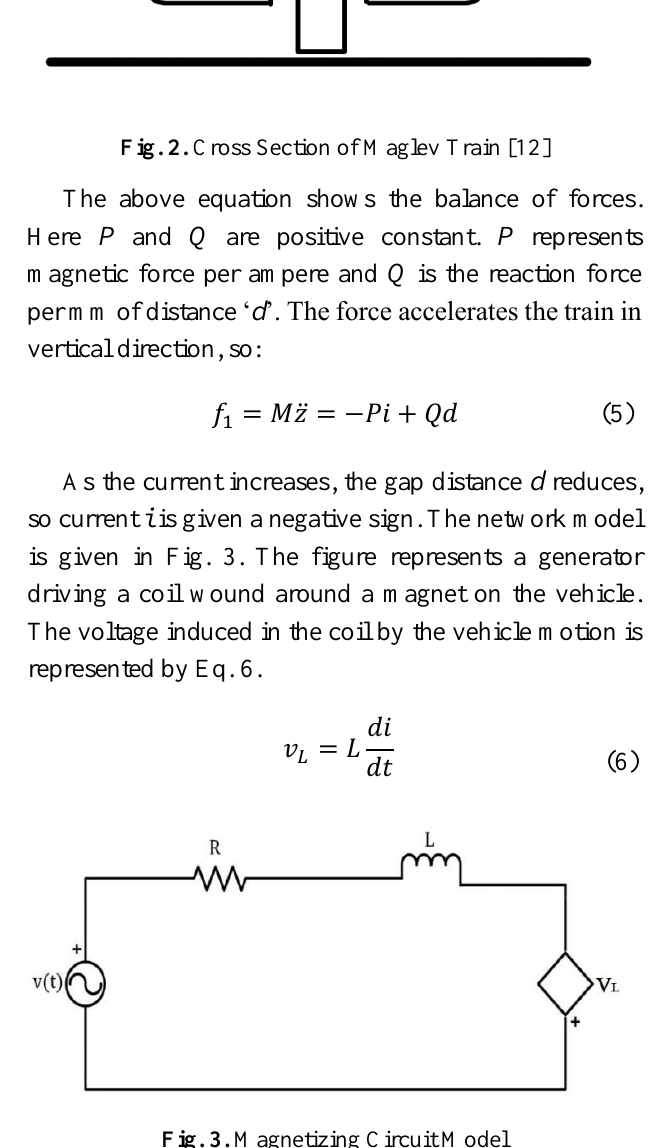
Fig. 3. Magnetizing Circuit